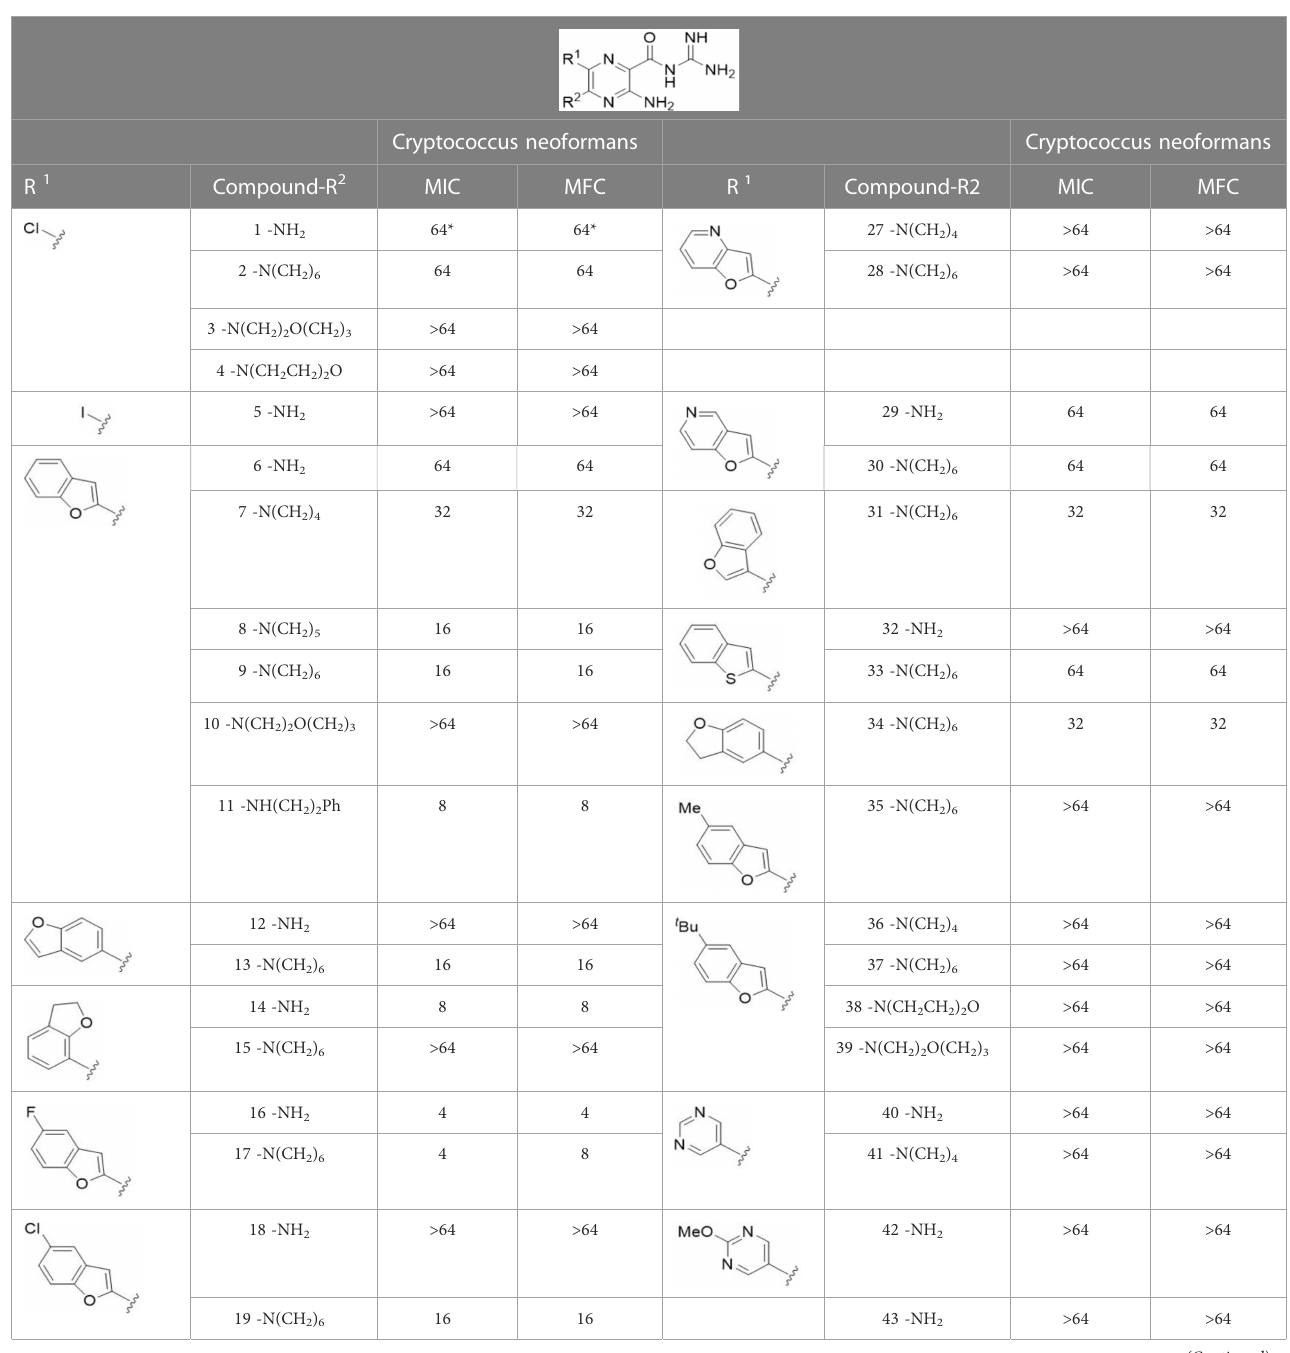
TABLE 1 Antifungal activity of amiloride analogs against Cryptococcus neoformans